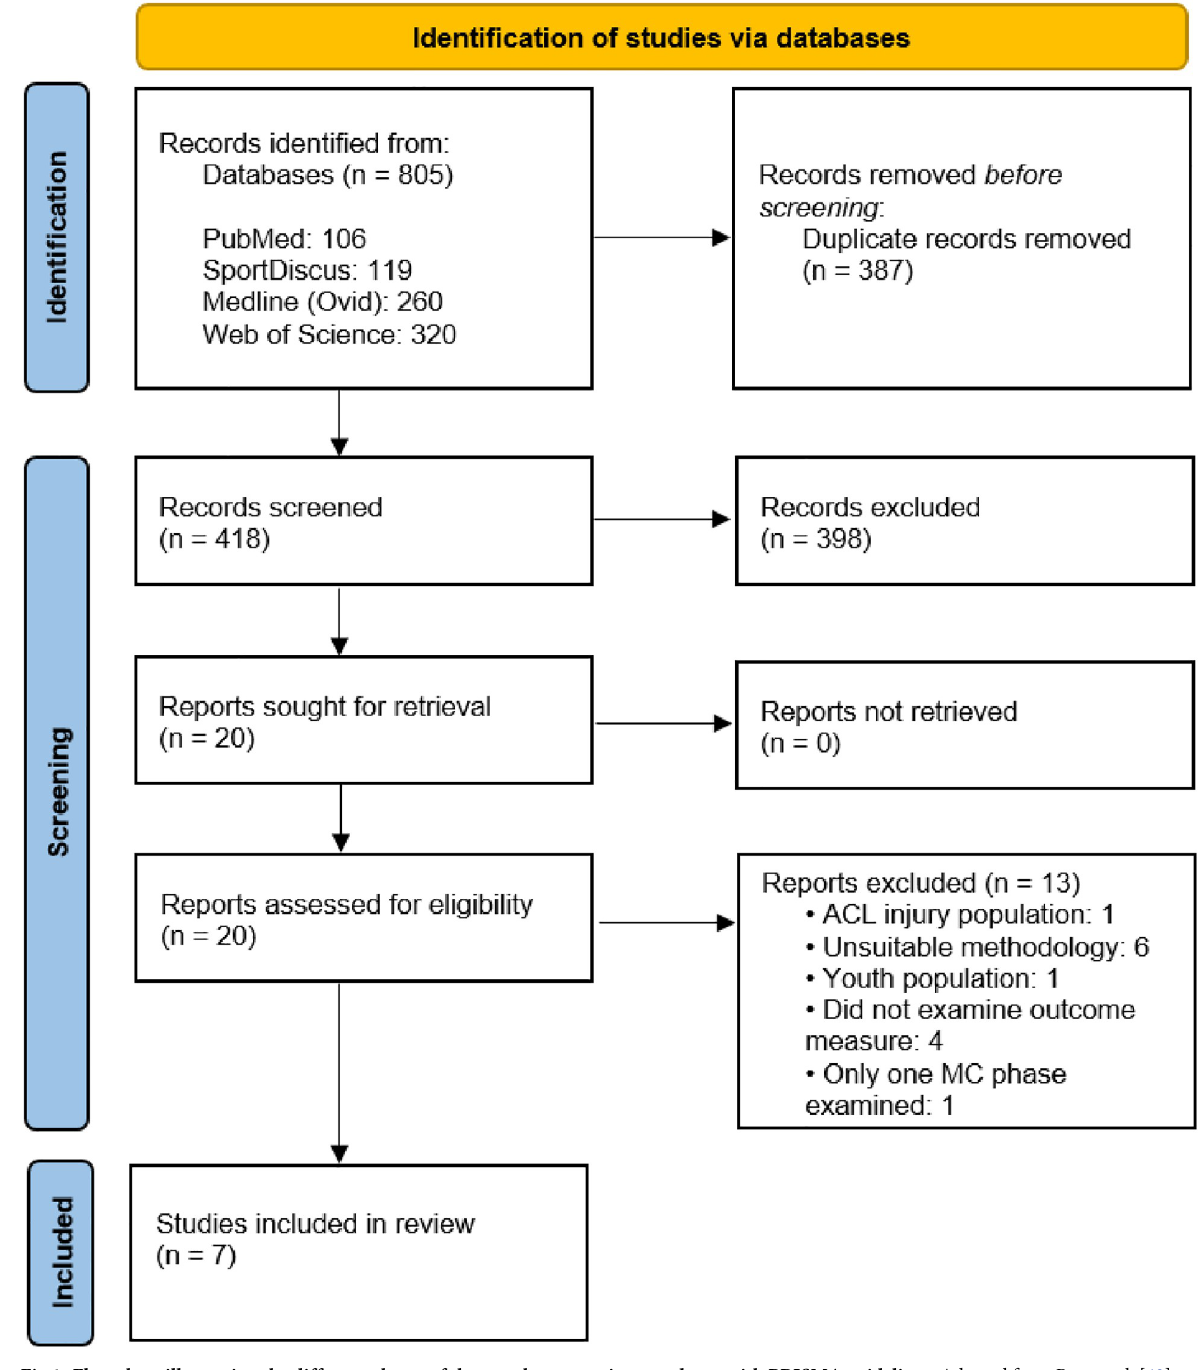
Fig 1. Flow chart illustrating the different phases of the search strategy in accordance with PRISMA guidelines. Adapted from Page et al. [43].